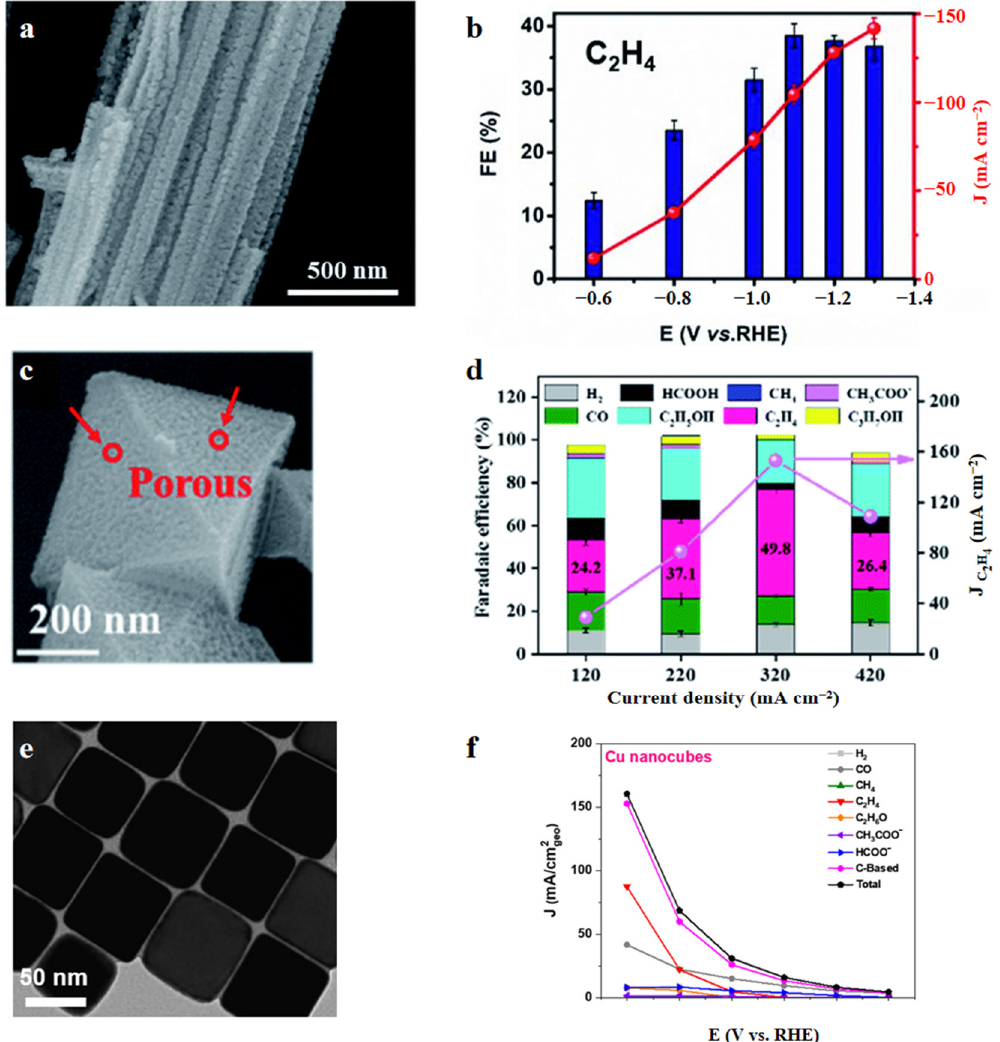
Figure 4. ( a ) SEM image of CuO nanowires; ( b ) FE and j C2H4 of OD-Cu in a flow cell. Reproduced with permission from Ref. [51]. Copyright 2020 The Royal Society of Chemistry. ( c ) SEM image of a single octahedral particle; ( d ) FE product and j C2H4 vs. total current density in a flow cell. Reproduced with permission from Ref. [52]. Copyright 2020 The Royal Society of Chemistry. ( e ) TEM image of Cu nanocubes; ( f ) j product vs. potential for Cu nanocubes in a flow cell. Reproduced with permission from Ref. [53]. Copyright 2019 American Chemical Society.